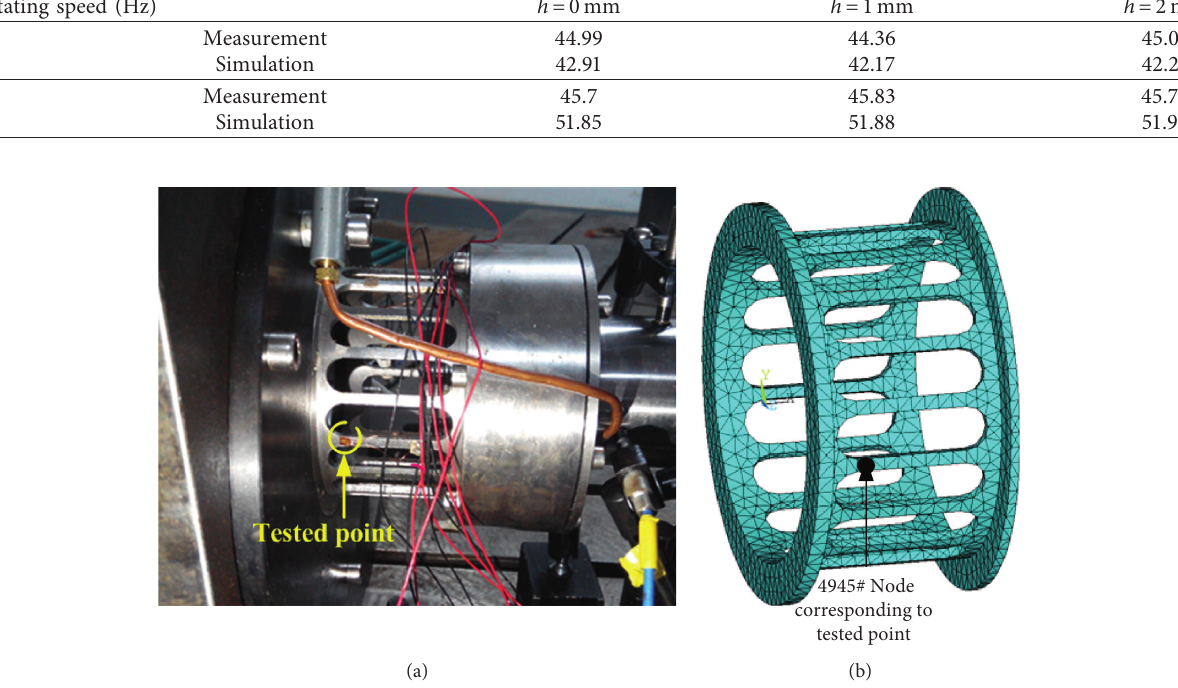
Table 8: Comparison of the vibration amplitudes for the measured and simulated results; unit: μ m. Rotating speed (Hz)